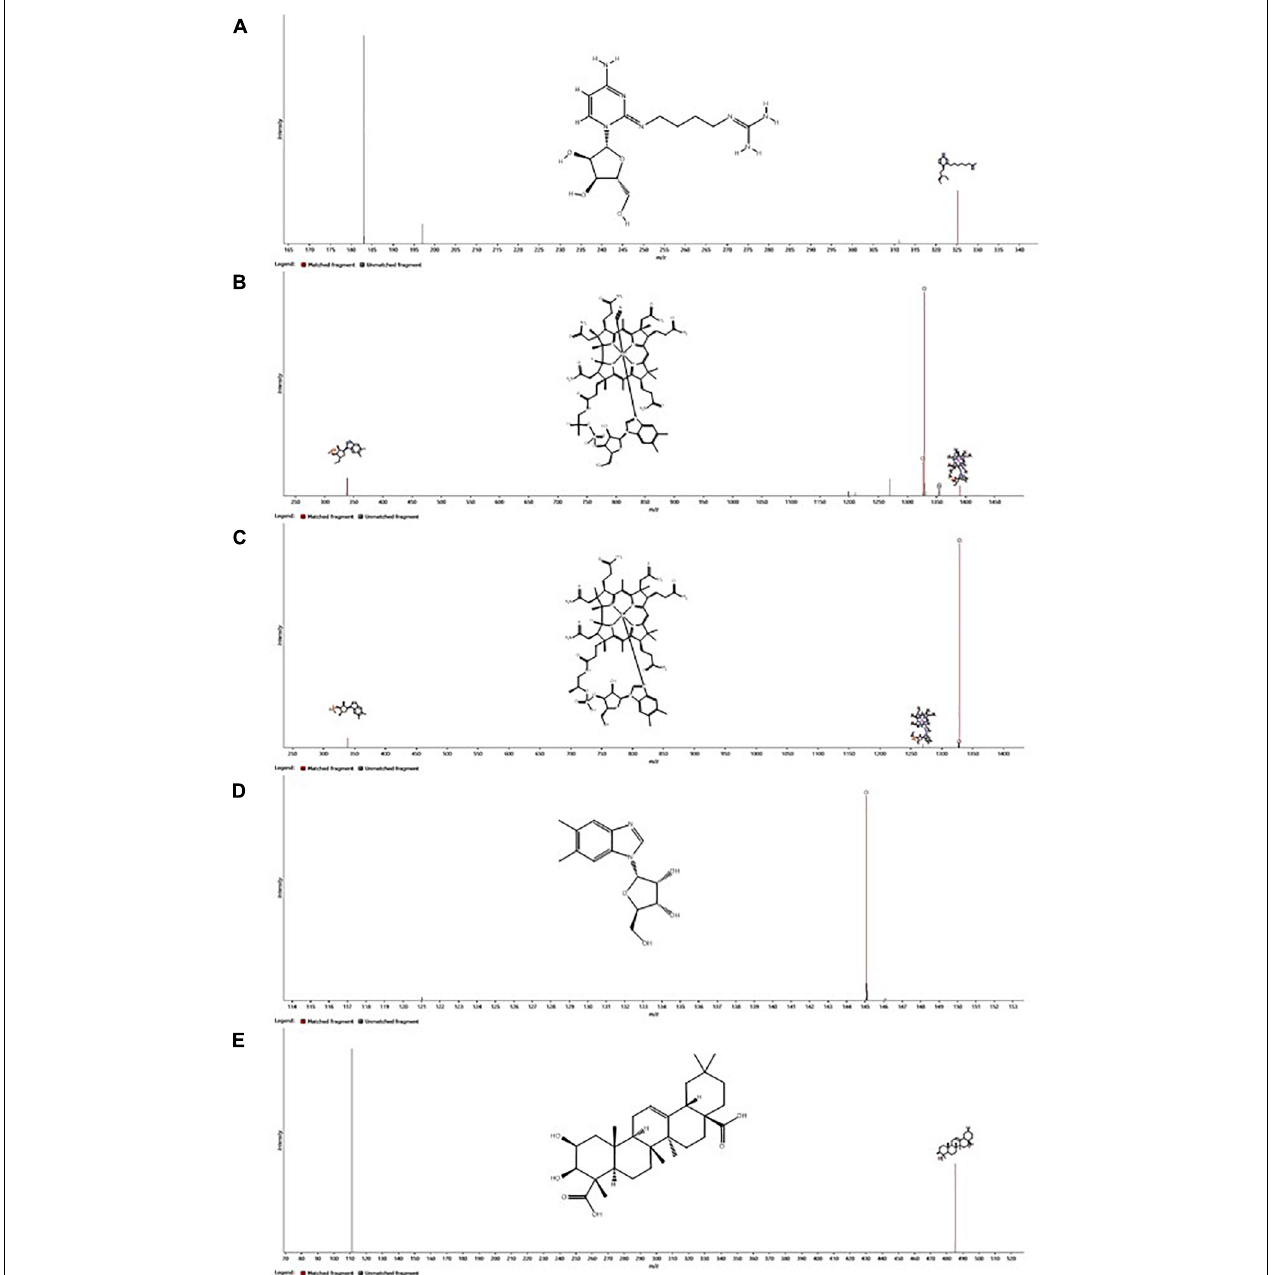
FIGURE 7 | Ion mobility enhanced MS E (HDMS E ) fragmentation spectra of the five most important putatively identified metabolites of N. maritimus , (A) agmatidine, (B) cyanocob(III)alamin, (C) cob(I)alamin, (D) α -ribazole, and (E) medicagenic acid, detected from the experimental culture medium in the negative ion mode. Fragment ions consistent with in silico fragmentation are highlighted. Inserts show the chemical structures of neutral